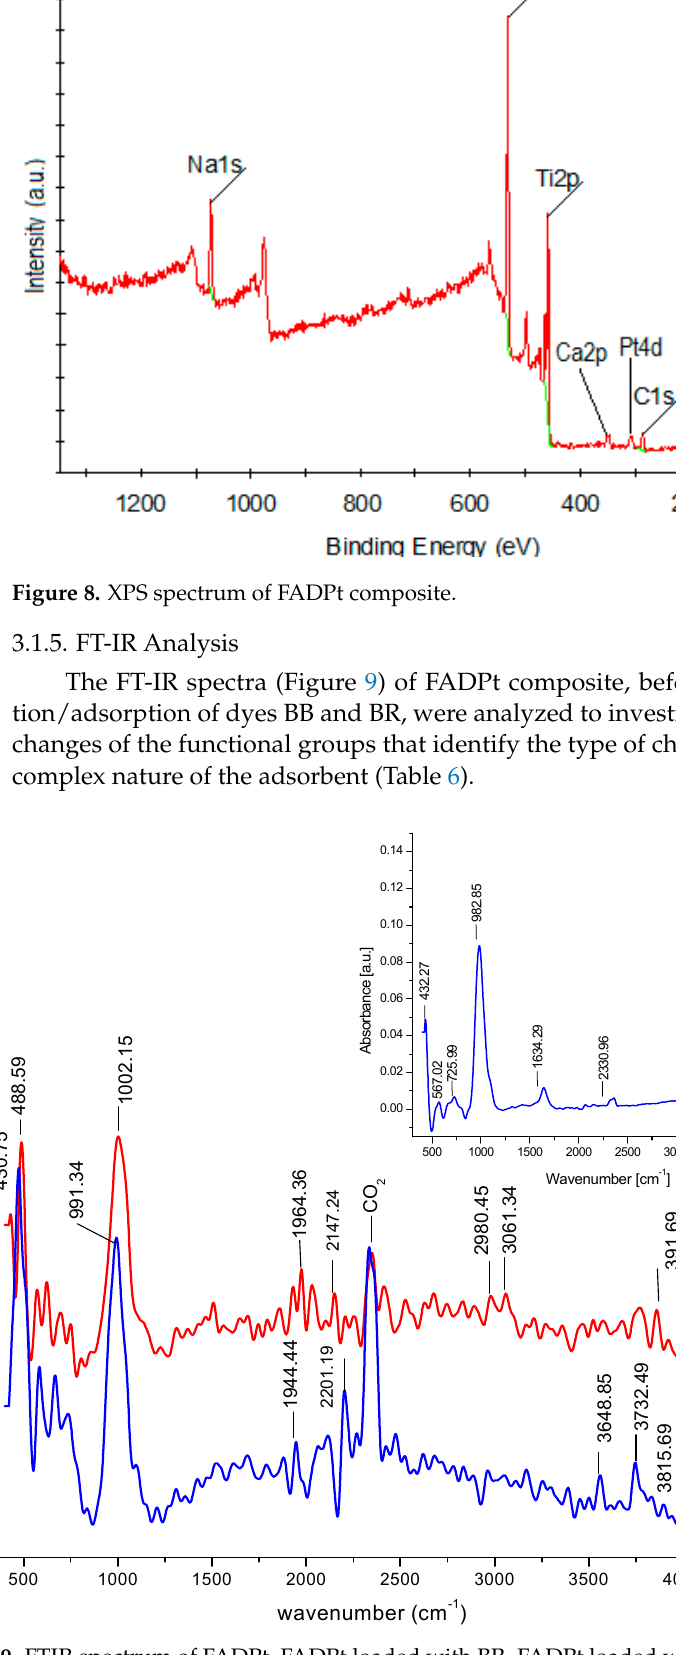
Figure 9. FTIR spectrum of FADPt, FADPt loaded with BR, FADPt loaded with BB.